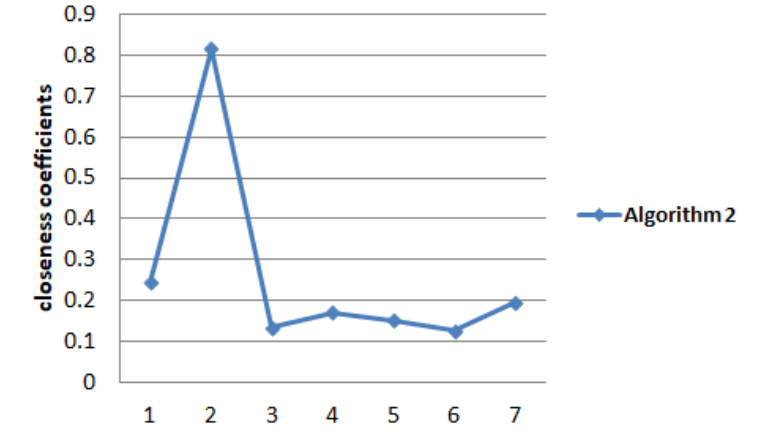
Figure 5. Ranking of